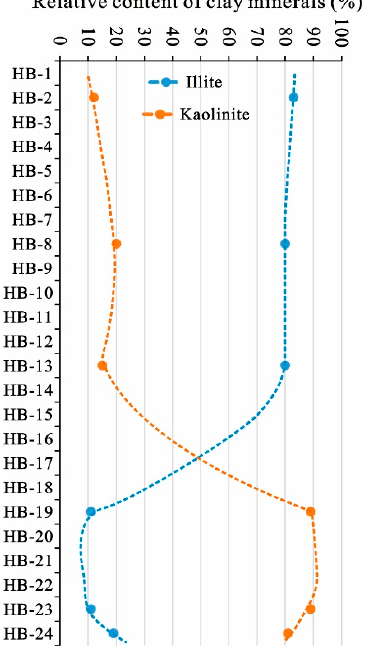
Figure 17. Relative contents of illite and kaolinite (on 100% clay mineral basis) in some samples from the Hebi No. 6 mine. Note that the dashed lines are the predicted trend of illite and kaolinite content and solid points are the tested data.